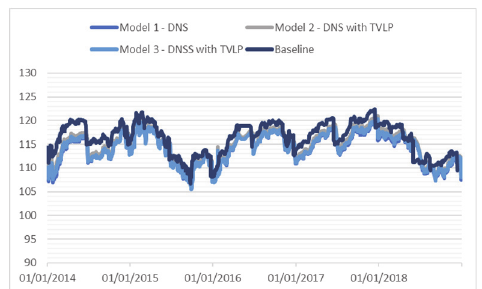
Fig. 6 . Fair price result comparison for FR0074 Fig. 7 . Fair price result comparison for FR0072